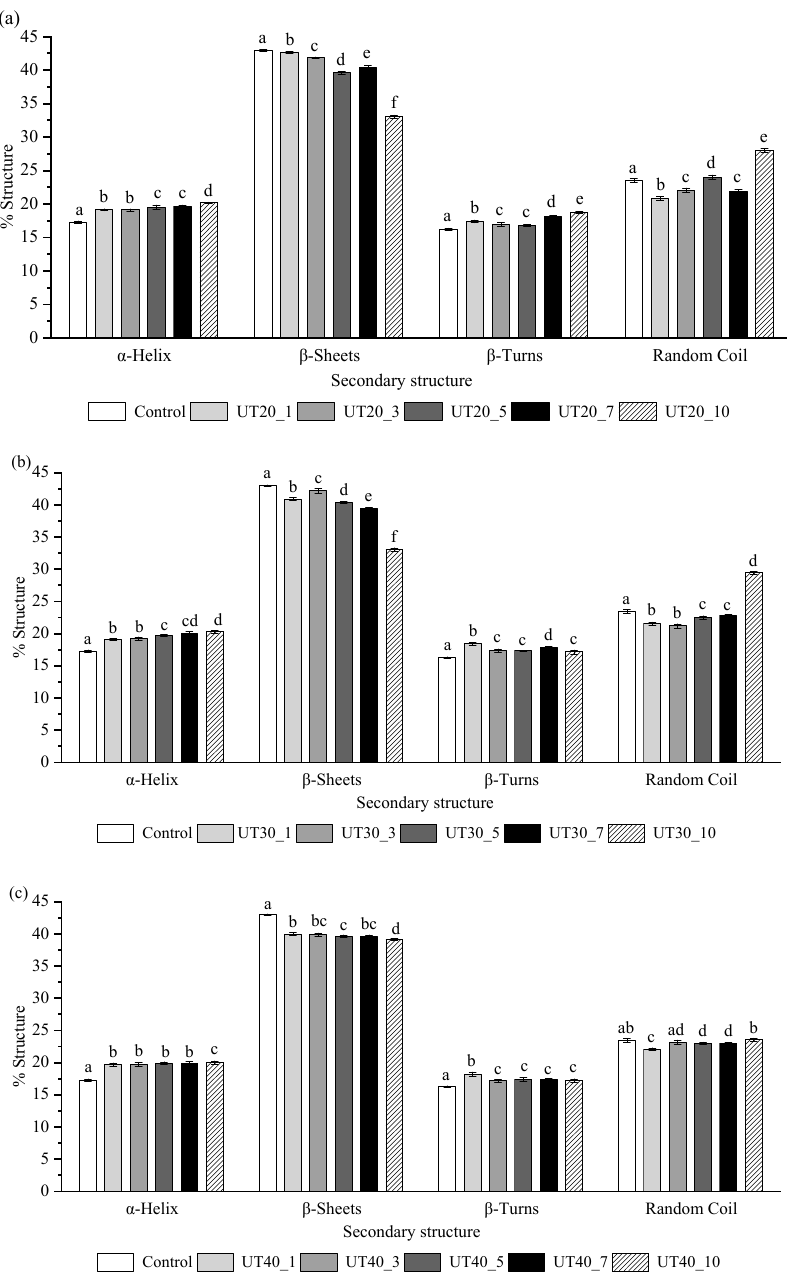
Figure 4. Secondary structure content of goat milk β -lactoglobulin samples treated at different amplitudes 20% ( a ), 30% ( b ), 40% ( c ) and different treat times (0, 1, 3, 5, 7, 10 min). Note: Completely different lowercase letter in the same HIU amplitude and secondary structure indicates significant difference at p <